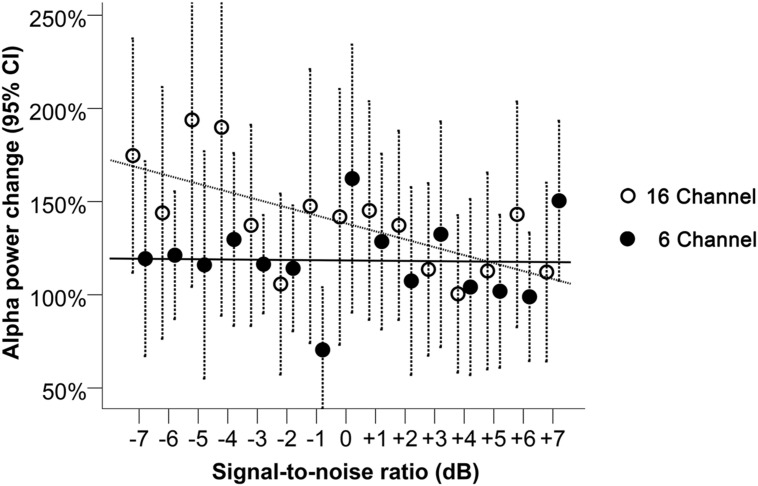
Alpha power change relative to baseline during 16- and 6-channel vocoded sentence recognition at SNRs between -7 and +7 dB. Dashed bars indicate 95% CI. The trend lines shown correspond to the best model fit, respectively, for the 16- and the 6-channel conditions.